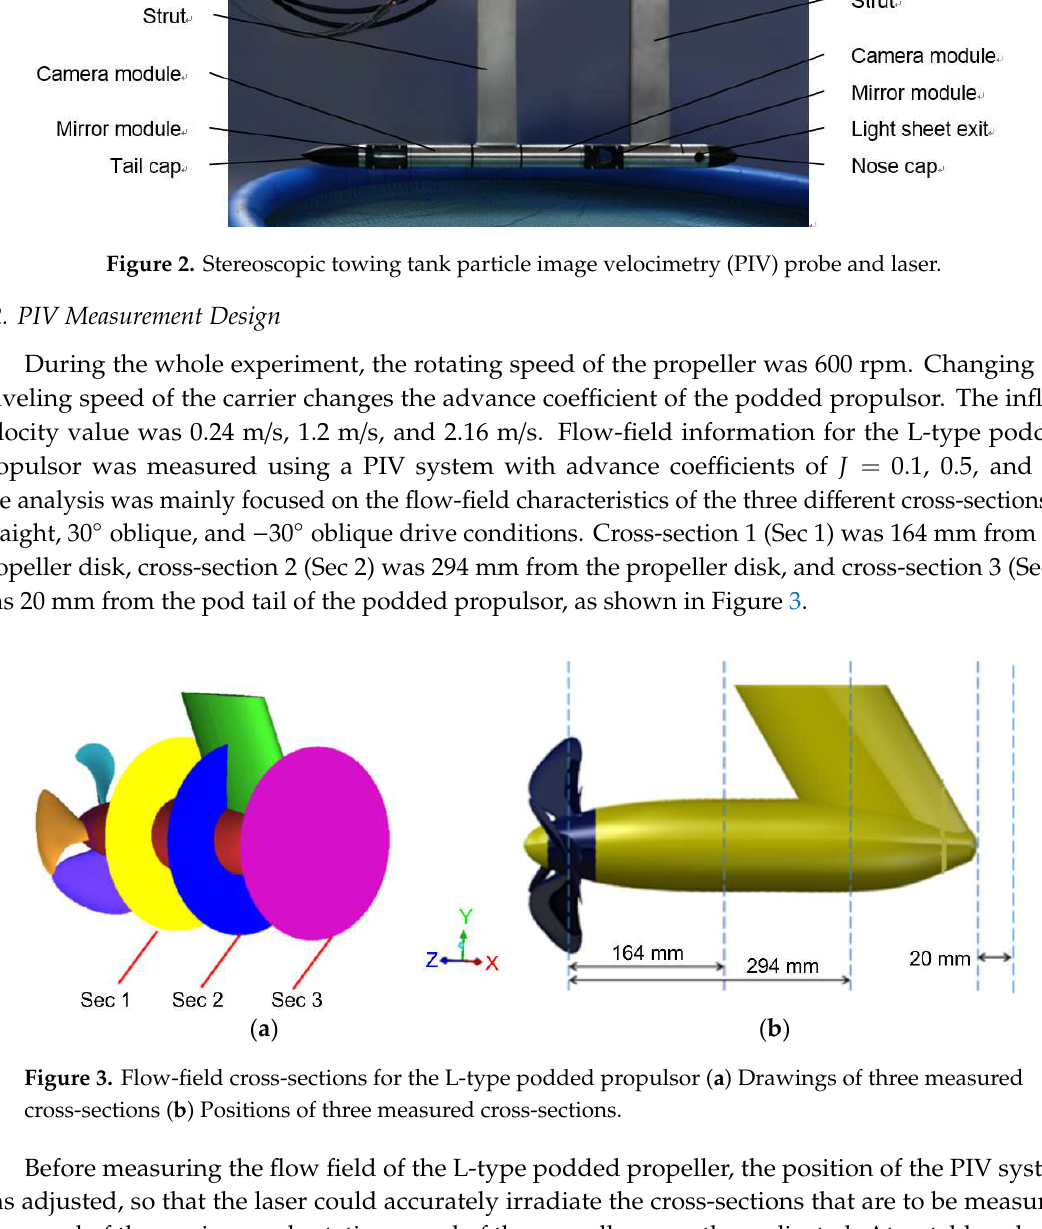
cross-sections ( b ) Positions of three measured cross-sections.